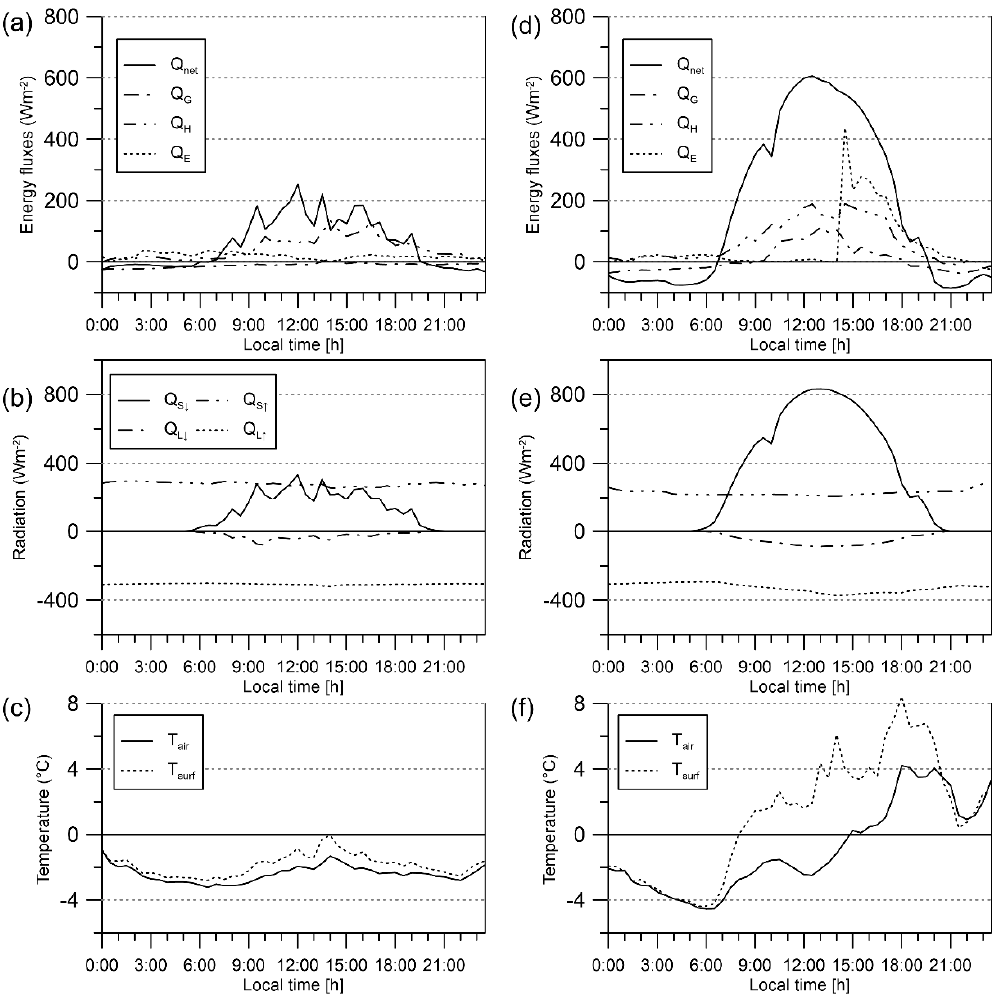
Figure 6. Daily regimes of surface energy budget components: day with overcast sky (left column, 18 February) and day with clear sky (right column, 15 February. ( a , d ): net radiation (Q net ), ground heat flux (Q G ), sensible heat flux (Q H ) and latent heat flux (Q E ). ( b , e ): incoming shortwave radiation (Q S ↓ ), outgoing shortwave radiation (Q S ↑ ), incoming longwave radiation (Q L ↓ ) and outgoing longwave radiation (Q L ↑ ). ( c , f ): air temperature (T air ) and ground surface temperature (T surf ).